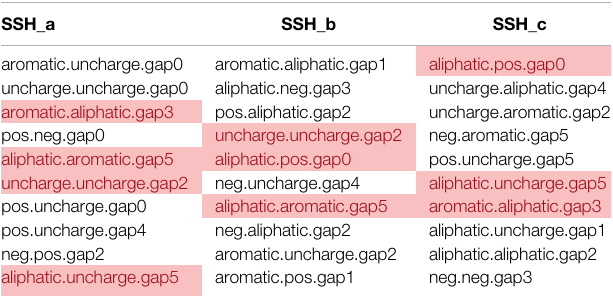
TABLE 4 | The top 10 CKSAAGP features of three sub-models. The features markedinredindicatethattheyexistinatleasttwosub-models(neg:negative charged group; pos: positive charge